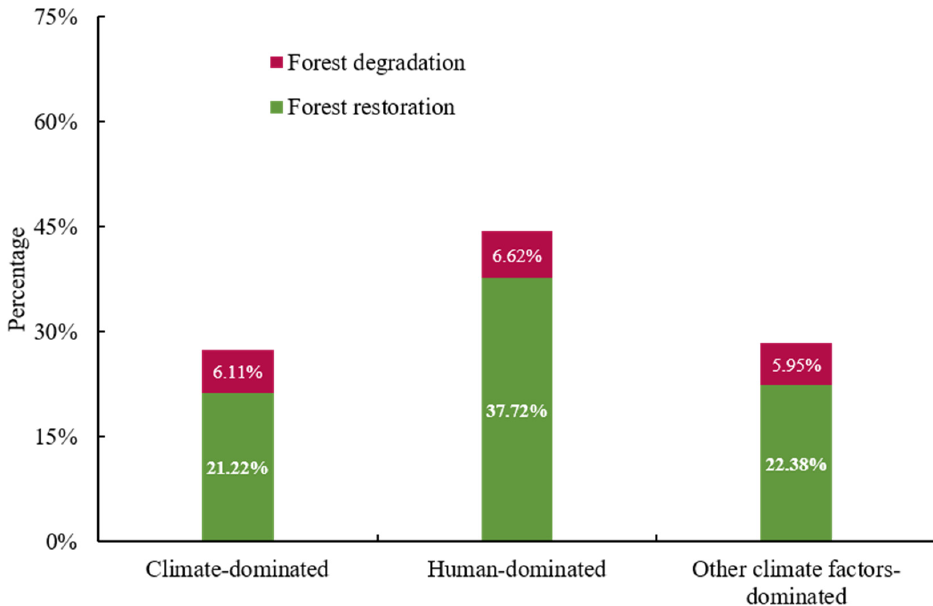
Figure 7. Spatial distribution of the climate-dominated, and other climate factors-dominated ( a , b ) new forest restoration and degradation areas, respectively; and the climate-dominated, and human-dominated ( c , d ) old forest restoration and degradation areas, respectively.